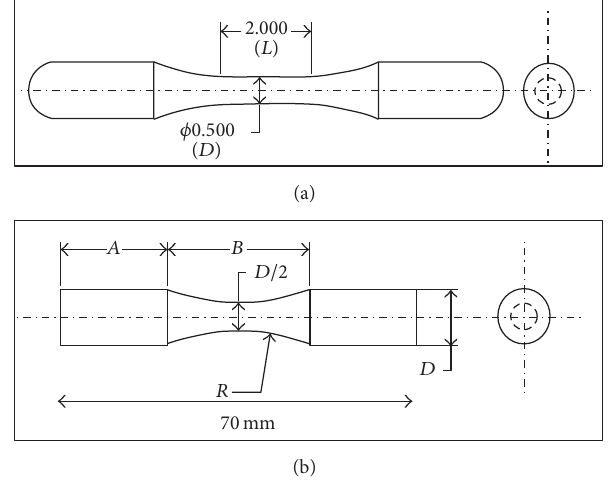
Figure 1: (a) Dimensions of the tensile sample in inch. (b) Dimen- sions of the fatigue sample, 𝑅 = 6.4 mm.